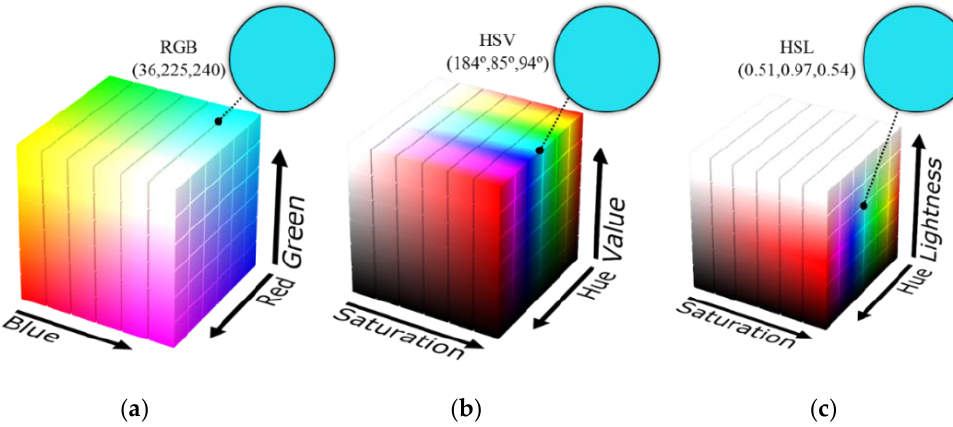
Figure 7. Expressing the color location and value according to each color model. ( a ) RGB color model, ( b ) HSV color model and ( c ) HSL color